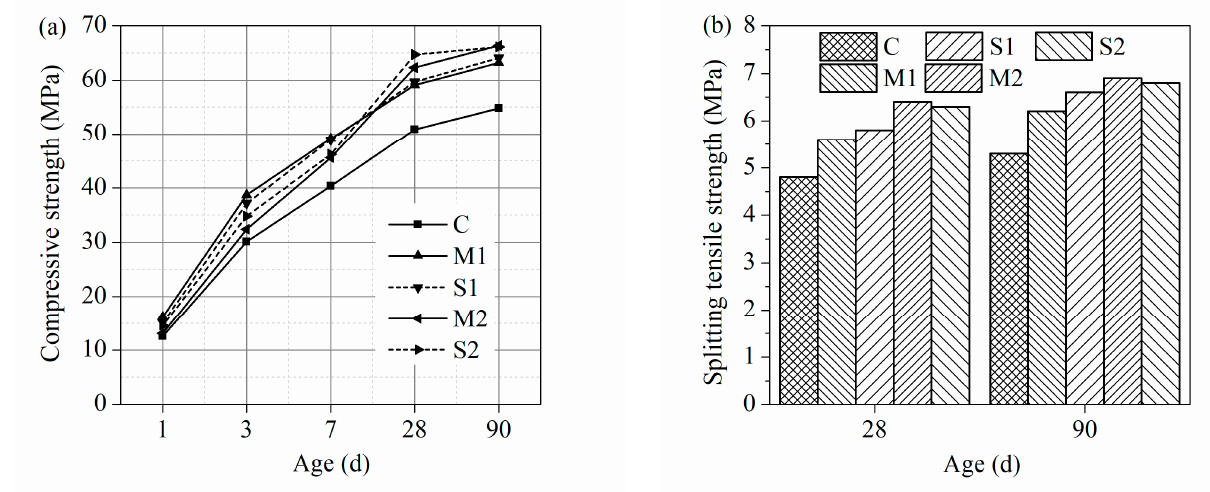
Figure 2. Mechanical strength of concrete: ( a ) compressive strength; ( b ) splitting tensile strength.